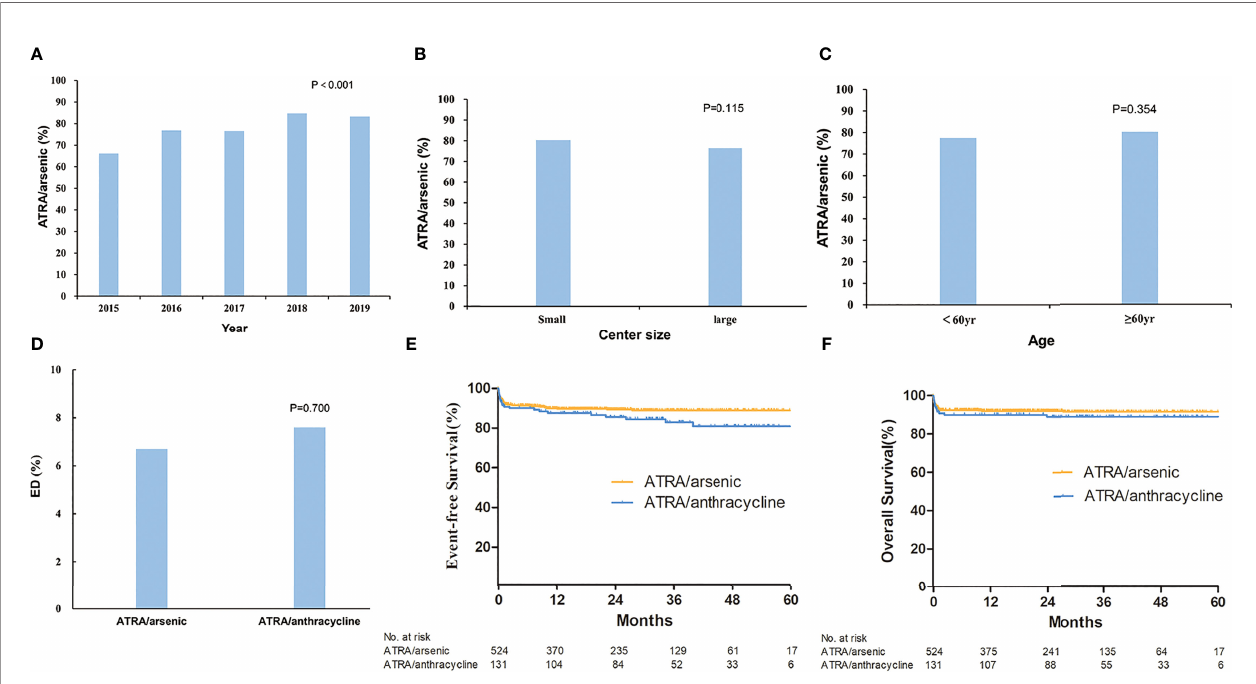
FIGURE 2 | The rate of all-trans retinoic acid (ATRA)/arsenic as fi rst-line treatment for acute promyelocytic leukemia and outcomes. Shown is the rate of ATRA/ arsenic as fi rst-line treatment which changed with the alteration of year (A) , center size (B) , and age (C) . The early death rate (D) and estimated survival (E, F) were compared between ATRA/arsenic group and ATRA/anthracycline